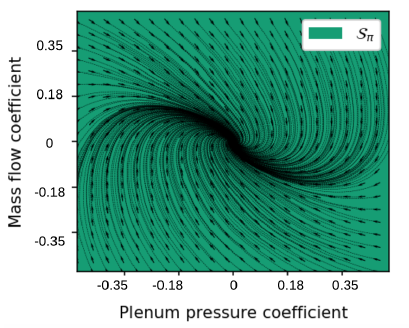
Figure 3: Safe region S π for a GAS equilibrium point.